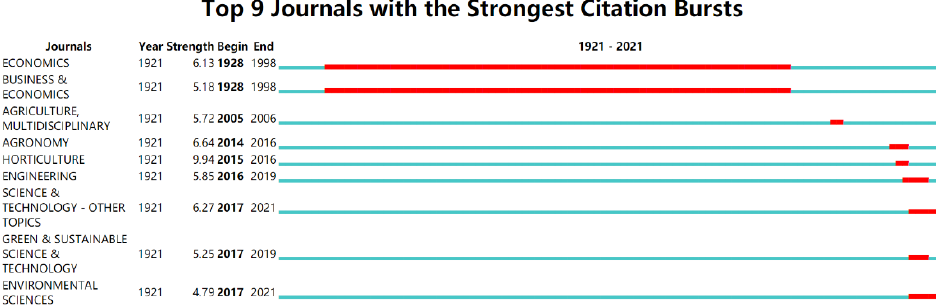
Figure 5. The Evolution of WOS Vegetable Price Research.